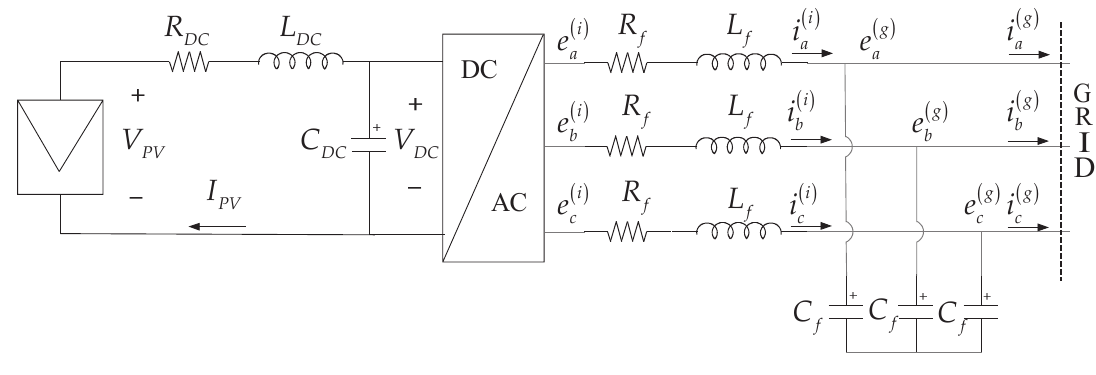
Figure 1. Photovoltaic (PV) unit scheme.